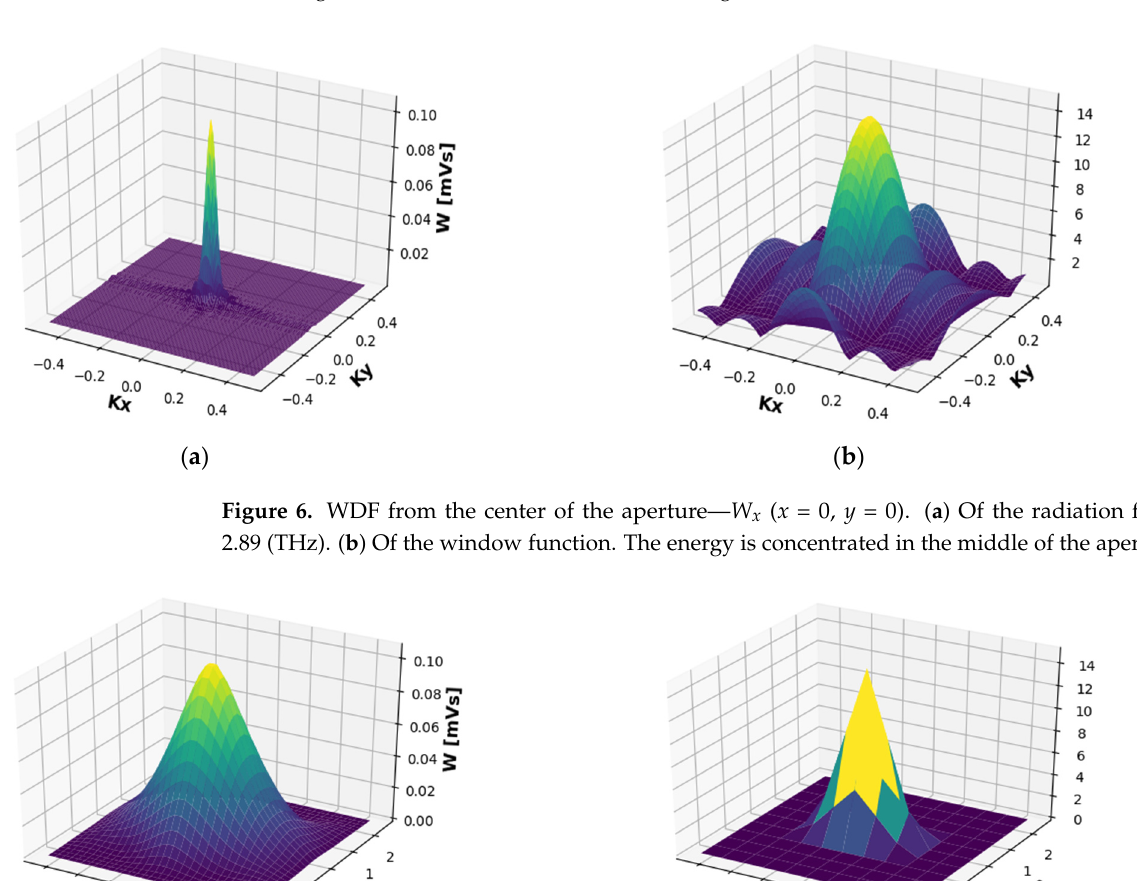
Figure 5. ( a ) Spatial profile of the output radiation field at the working frequency of 2.89 (THz) and the test signal and ( b ) the window function (test signal).